Question: From the figure, is the trend upward or downward?
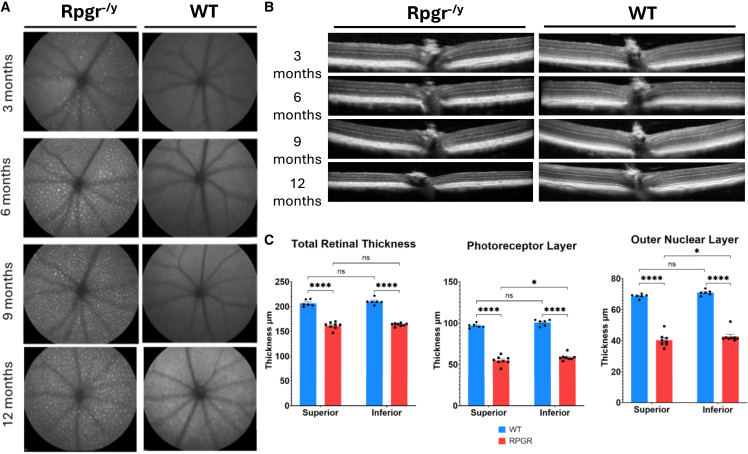
Answer: increasing